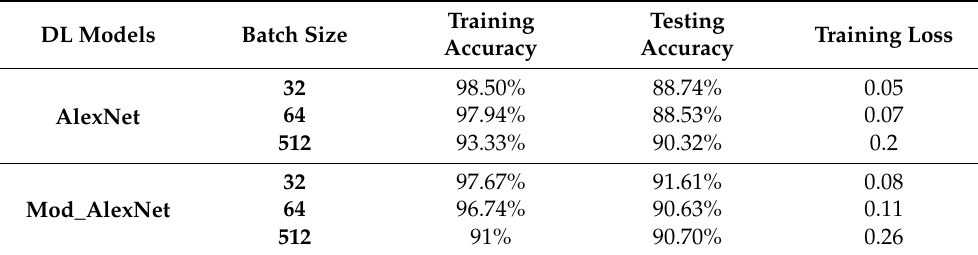
Table 5. SGDM optimizer performance (3 epochs and batch sizes: 32, 64, and 512).